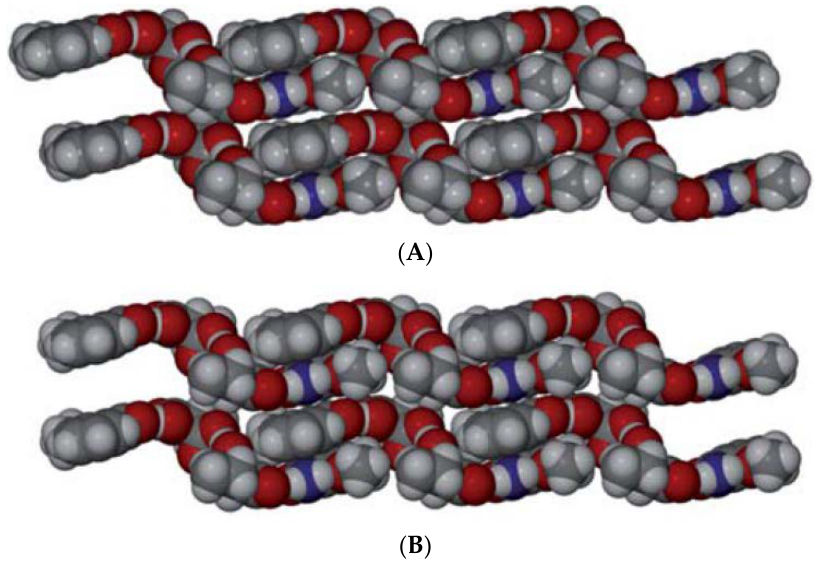
Figure 27. Packing of ethenzamide-ethyl malonic acid (1:1) cocrystal ( A ) form 1 and ( B ) form 2 [Reprinted from [216] with permission. Copyright 2010 Royal Society of Chemistry].